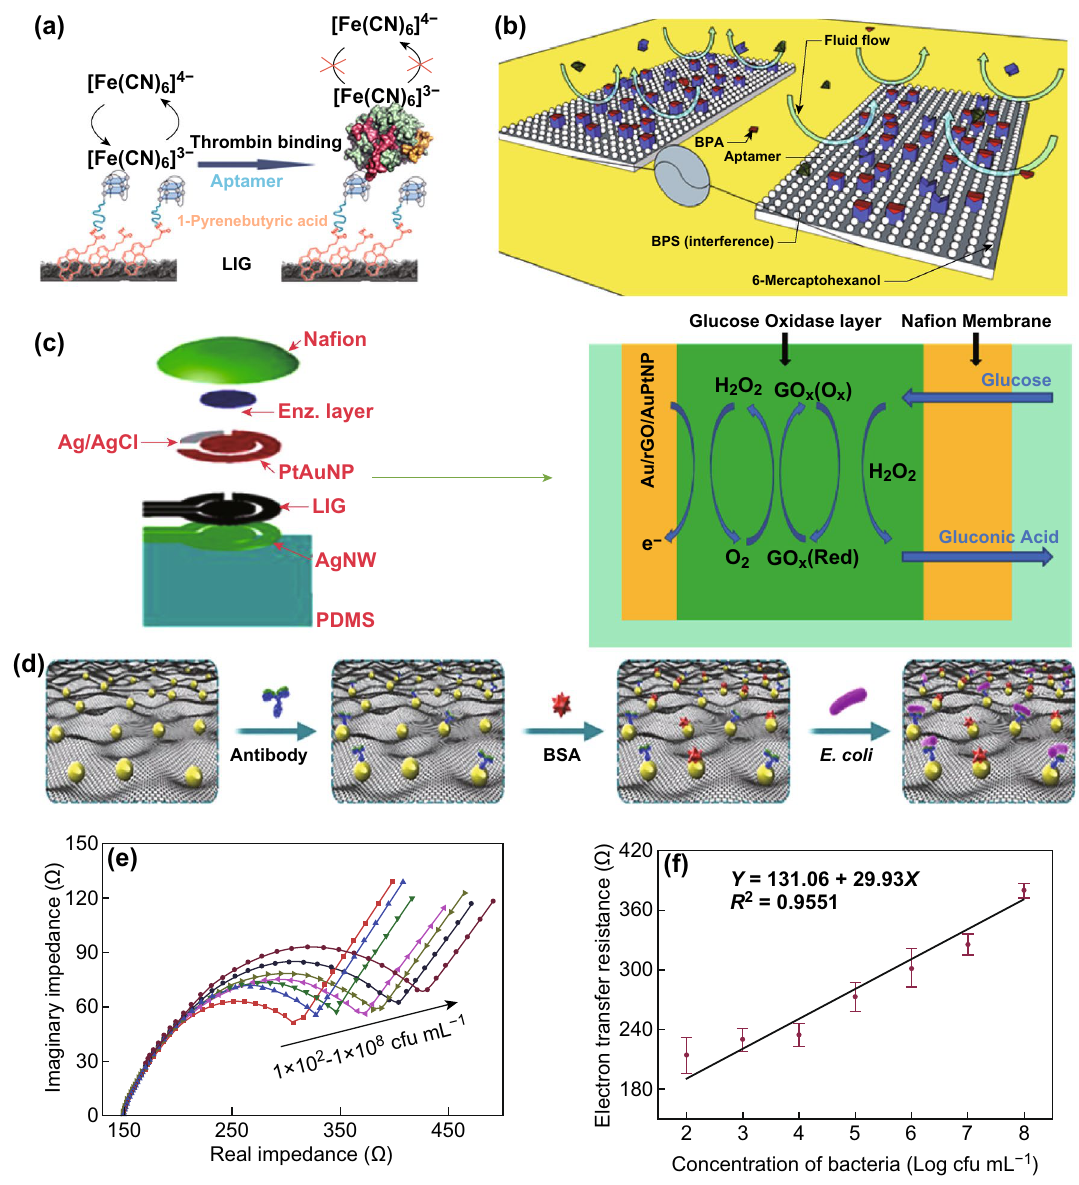
Fig. 4 Various specific binding sensors. Schematic of a thrombin sensor, b BPA sensor, and c enzymatic glucose biosensor sensor. Adapted with the permission from a Ref. [50], Copyright 2017 American Chemical Society; b Ref. [51], Copyright 2016 American Chemical Society; c Ref. [52], Copyright 2018 Elsevier B.V. d Schematic illustration of the AuNPs-LIG-based immunosensor for the detection of E. coli O157:H7. e Nyquist plots of E. coli sensor. f Calibration curve of the impedance response with the concentrations. d – f Adapted with the permission from Ref. [60], Copyright 2019 Elsevier